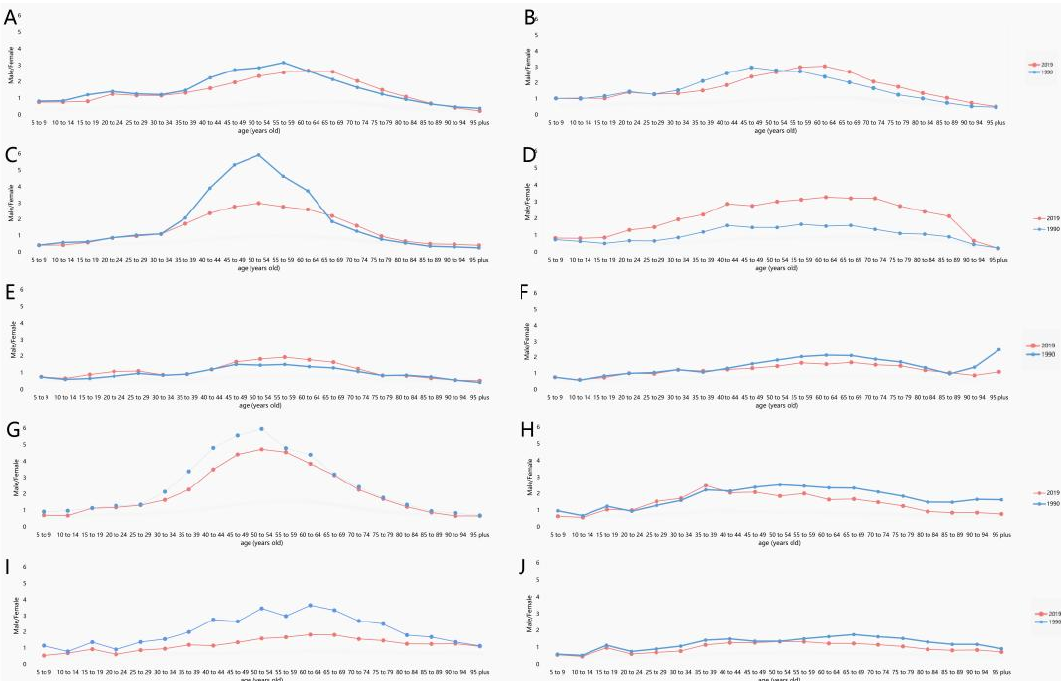
Figure 2. The ratio of male to female incidence of OC among different age groups in 1990 and 2019. ( A ) Japan, ( B ) USA, ( C ) Russian, ( D ) China, ( E ) Indonesia, ( F ) Mexico, ( G ) Brazil, ( H ) India, ( I ) Bangladesh, ( J ) Pakistan. (Countries are ranked from highest to lowest in SDI.)